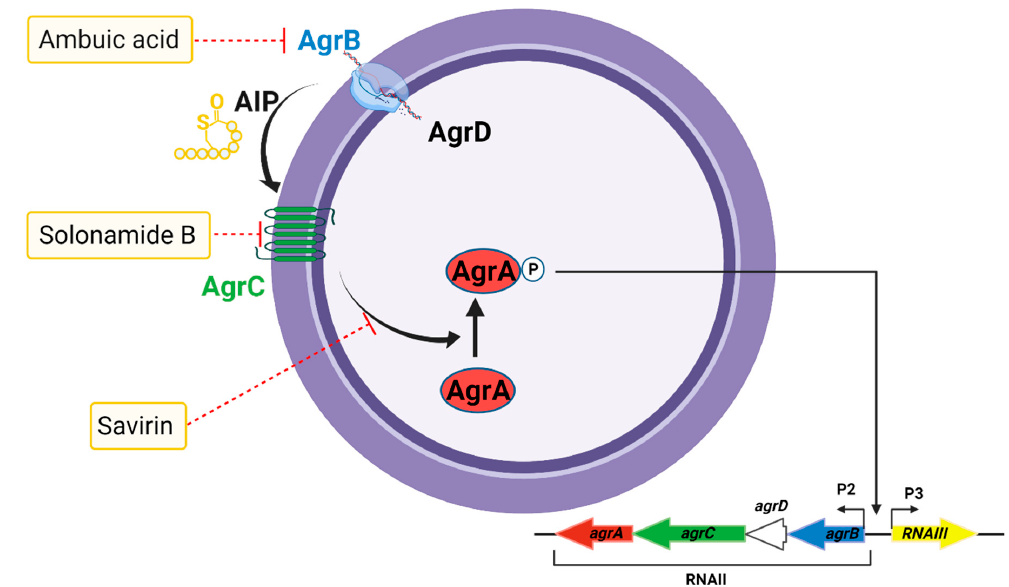
Figure 7. Accessory gene regulator (agr) quorum sensing system in S. aureus as a target for the inhibition of virulence factor production. The agr system regulates the production of pore ‐ forming toxins (PFTs) and phenol ‐ soluble modulins (PSMs), which are responsible for disease pathogenesis and tissue injury. Several agents can target the agr system to inhibit virulence factor production, including ambuic acid (inhibition of auto ‐ inducing peptide (AIP) production), solonamide B (inhibition of AIP activation of AgrC), and savirin (inhibition of AgrA downstream of AIP sensing).